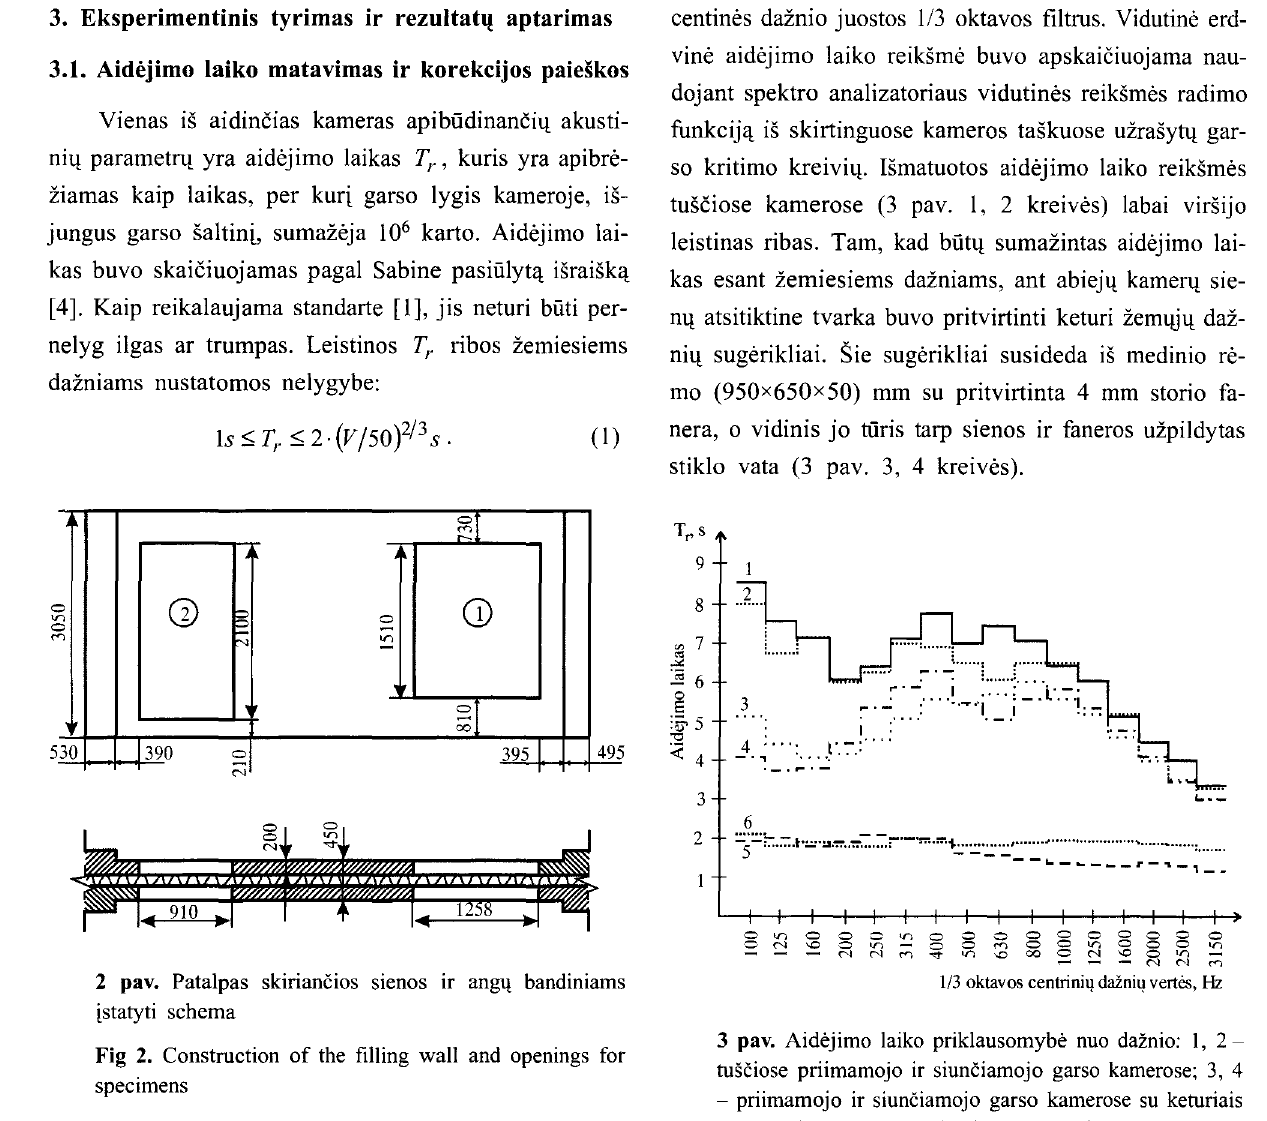
Fig 2. Construction of the filling wall and openings for specimens